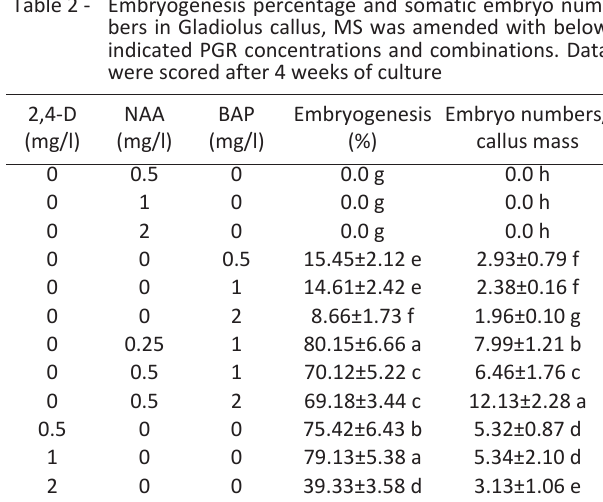
Values are expressed as means ± standard errors of three repli- cates of two experiments; within each column means followed by the same letter are not significantly different at p≤0.05 according to Duncan’s Multiple Range Test